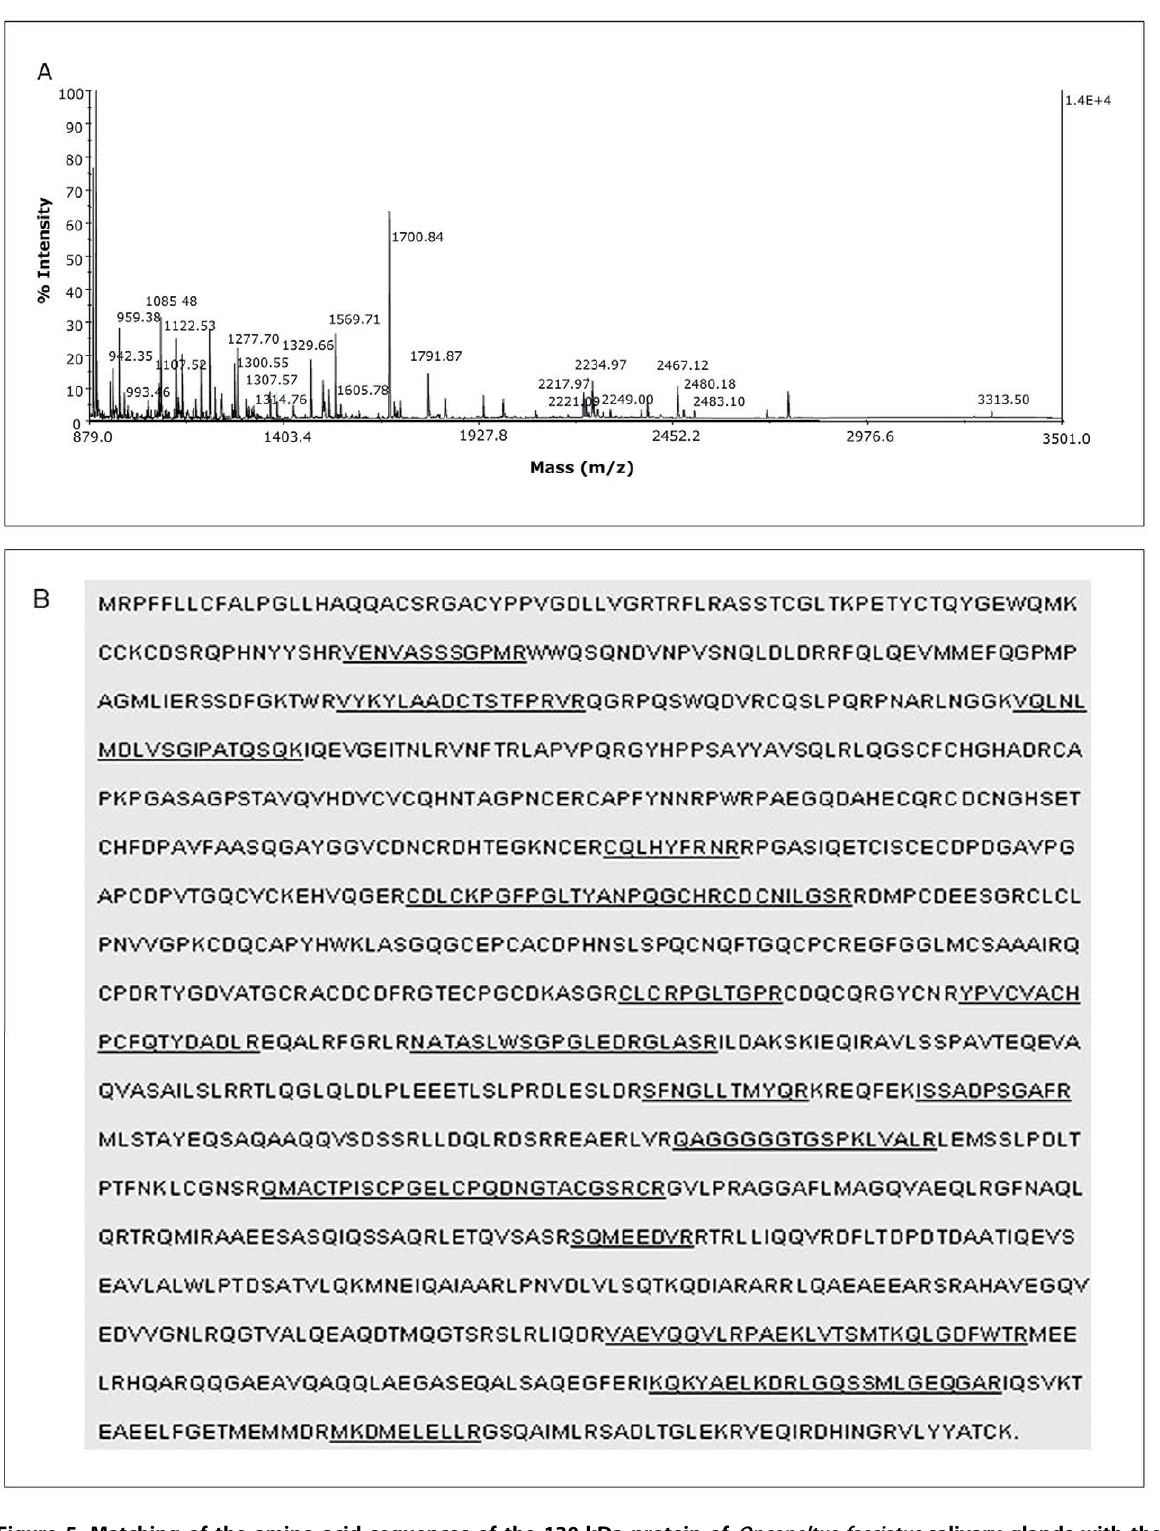
PLOS ONE | www.plosone.org 4 October 2012 | Volume 7 | Issue 10 |